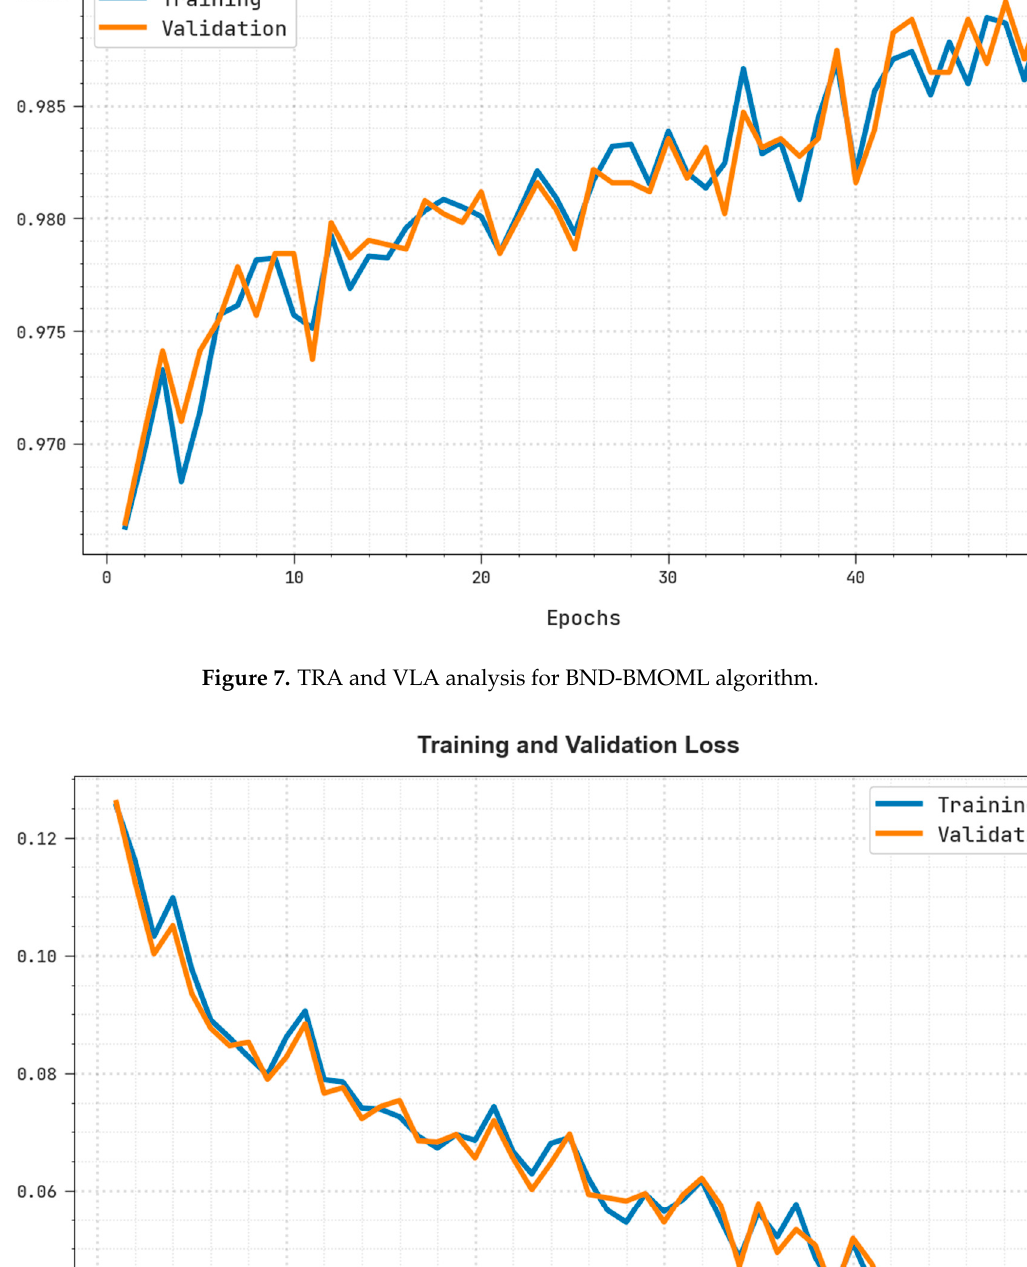
VLA. The VLA was seemingly greater than the TRA.